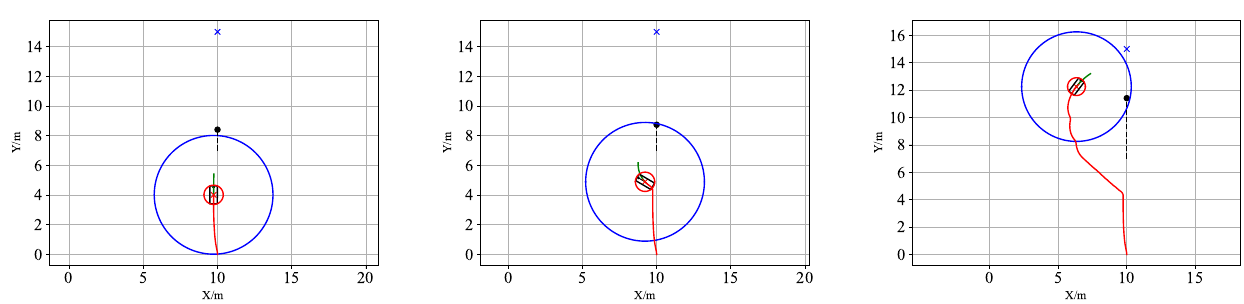
Figure 12. DWA algorithm for overtaking situation in compliance with